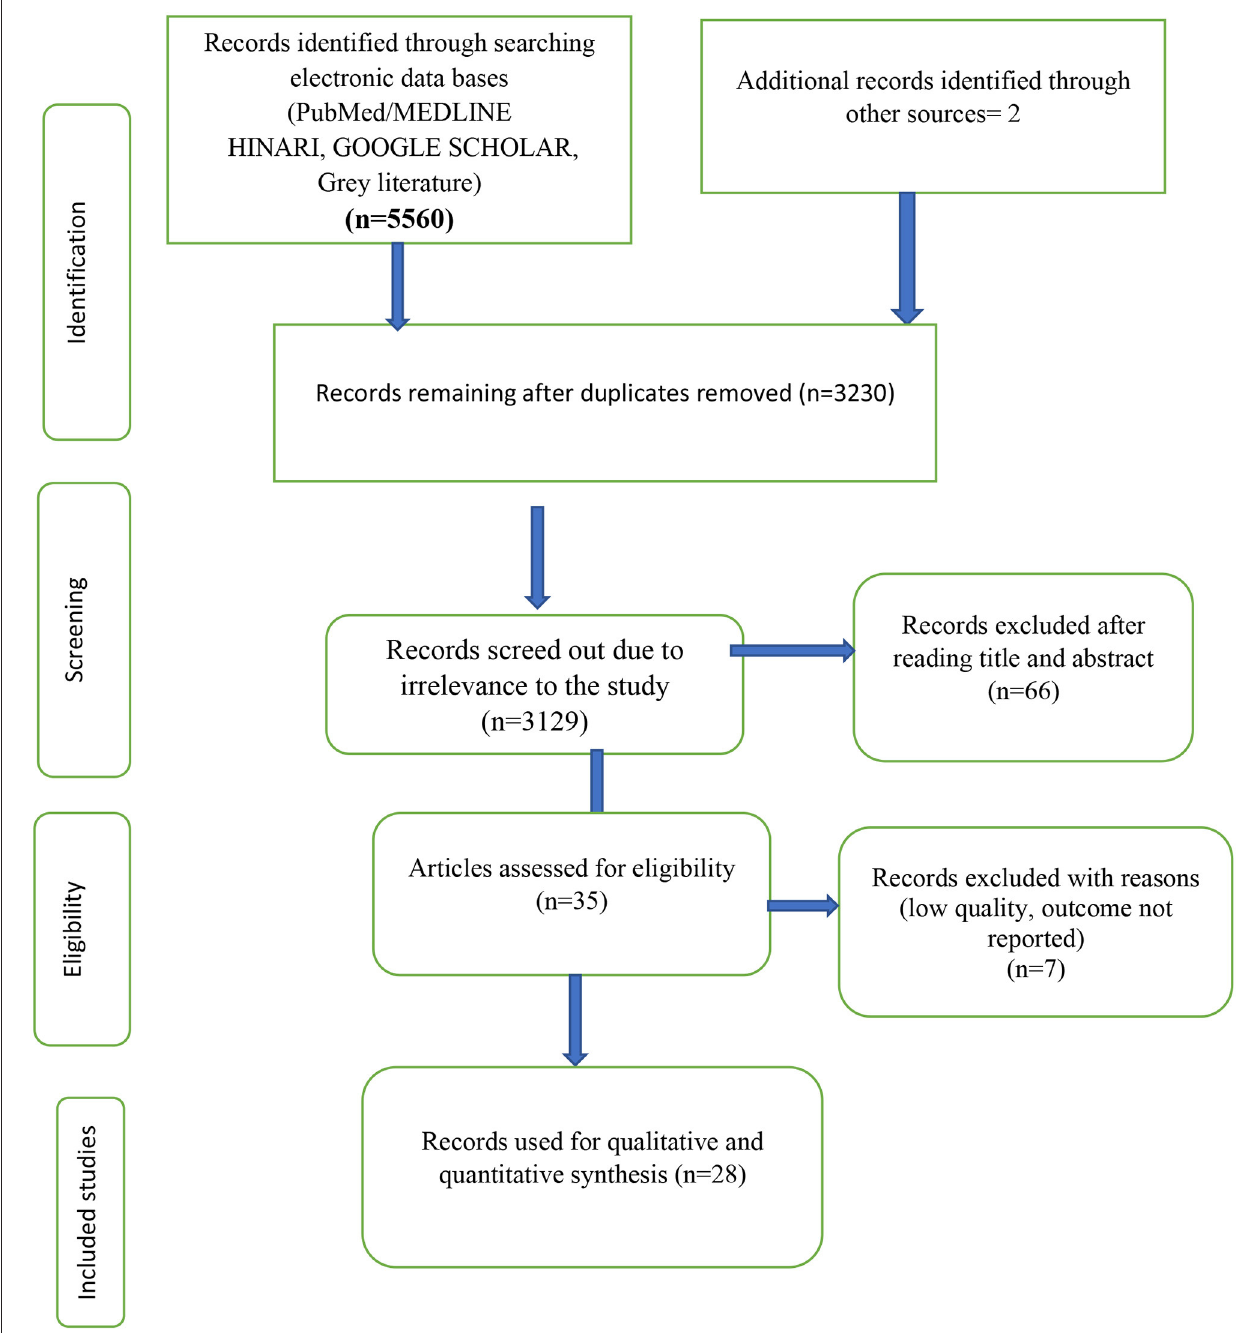
FIGURE 1 | Prisma flow diagram of article selection for systematic review and meta-analysis on the prevalence of internet addiction and its associated factors among students in Africa.